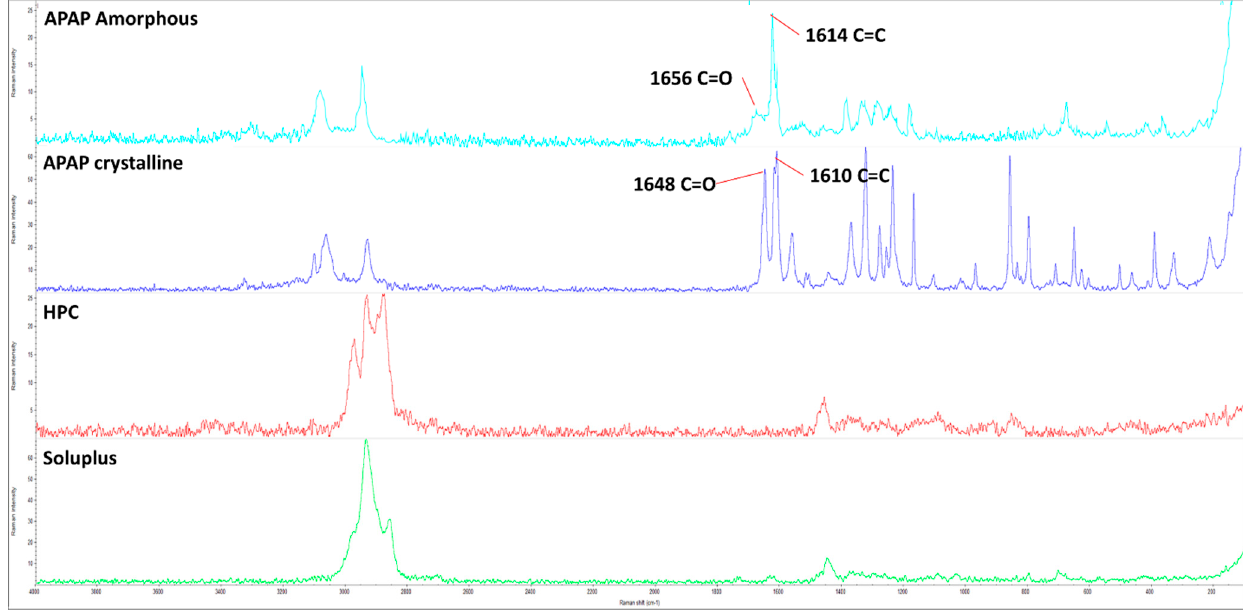
Figure 7. Raman spectra of the amorphous APAP (light blue), crystalline APAP (dark blue), HPC (red), and Soluplus (green) polymer.